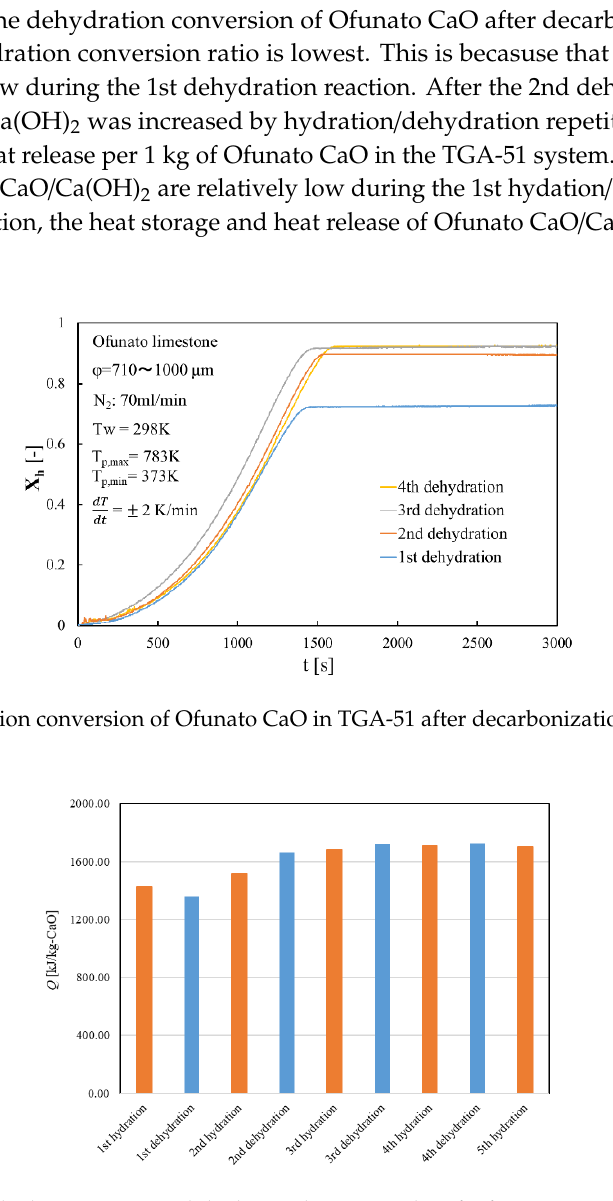
Figure 12. The heat storage and the heat release per 1 kg of Ofunato CaO in TGA-51.